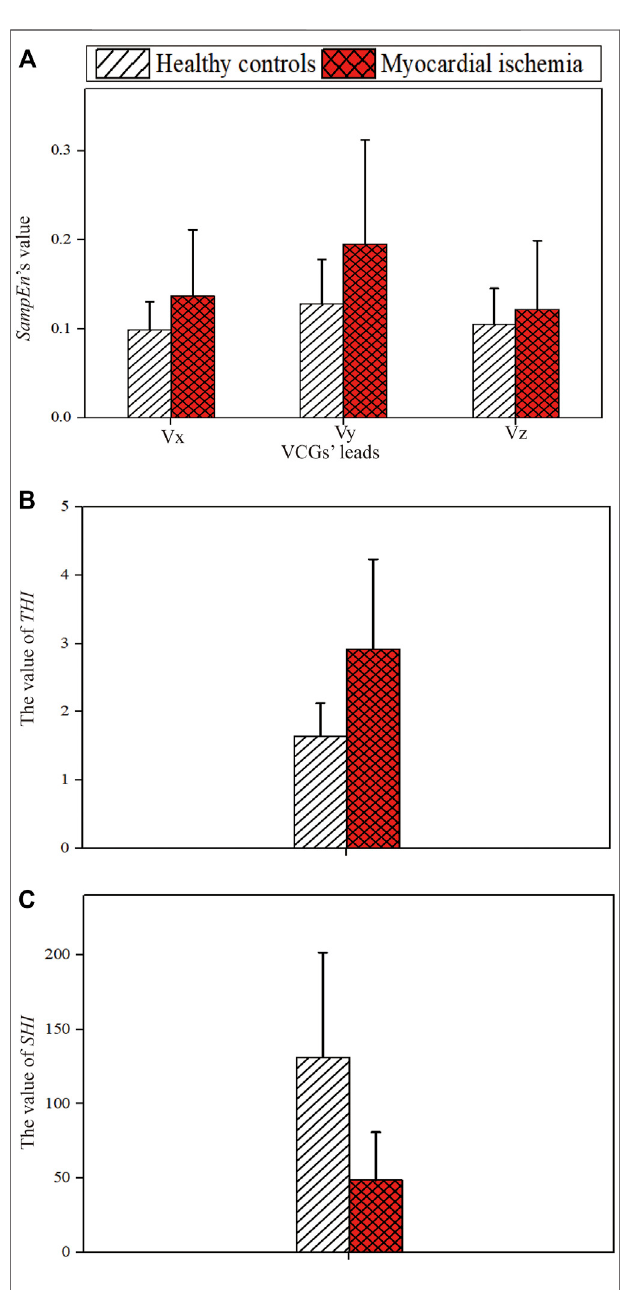
FIGURE 6 | Deep features extracted from VCGs. (A) SampEn ’ s value. (B) THI. (C) SHI.